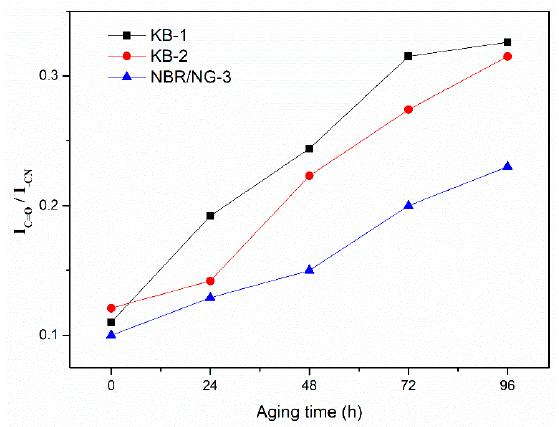
Figure 18. Relative content changes of C = O in KB-1, KB-2, and NBR / NG-3 at di ff erent aging times.